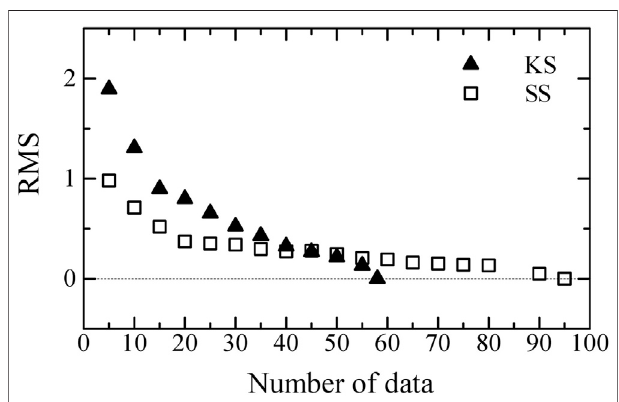
FIGURE 7 | RMS between the spectral ratio of S-wave to P-wave using seismic data to the full datasets, for KS and SS stations. The number of full datasets is 58 and 95 for KS and SS stations, respectively.